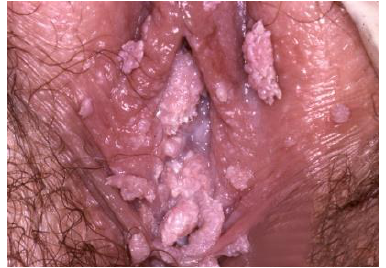
Figure 9. HPV infection.